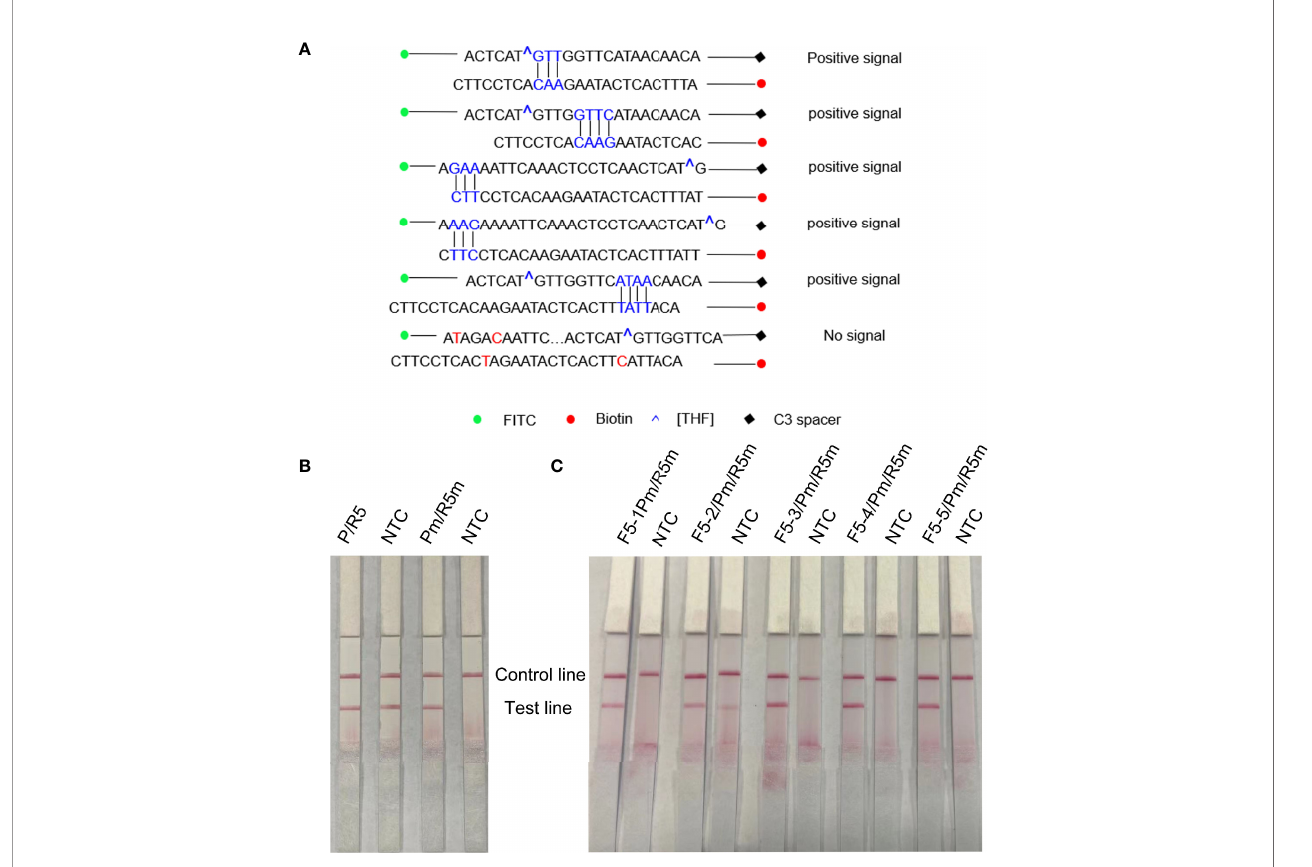
FIGURE 4 | Screening of forwarding primers using RPA-LFS; 1 µl of 2 × 10 9 copies/ml was used as the template for the reaction. (A) Sequence analysis of primer – probe combination (P/R5) and its modi fi cation; the number of consecutive matching bases is greater than three and is connected by vertical lines. (B) RPA-LFS reaction was performed using reverse primers and probes. (C) Five forward primers were combined with probe and reverse primer for WSSV ampli fi cation, respectively. NTC was a no-template negative control. The primer names are shown at the top of each